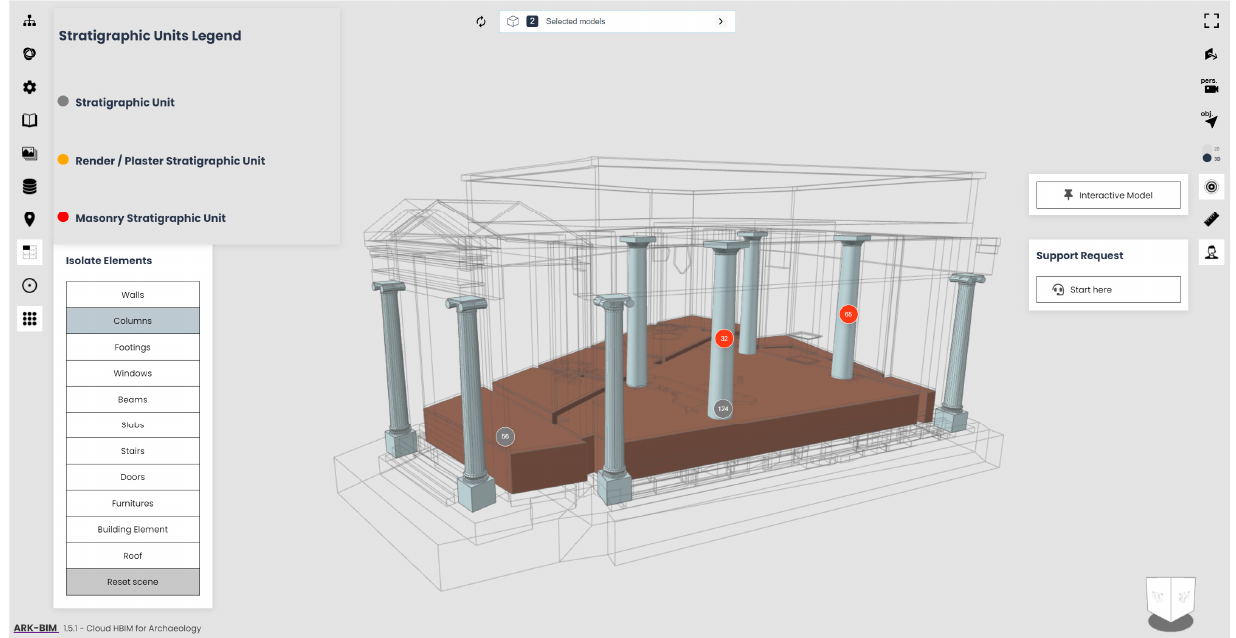
Figure 12. The Domus Regia HBIM model inside the ARK-BIM environment. Additional plugins are on the left and right side of the window: details on picked stratigraphic units and “IfcColumn” isolated in the 3D